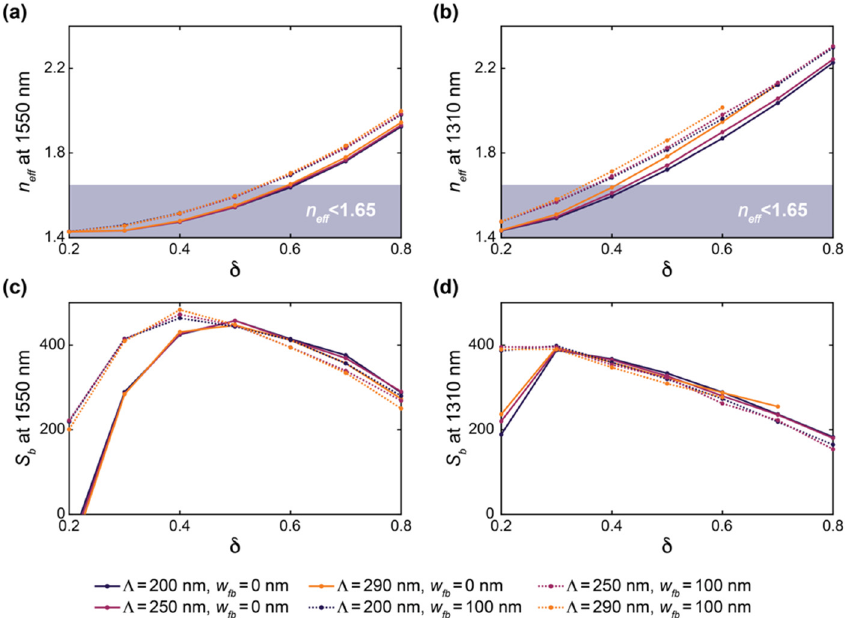
Figure 5. ( a , b ) Simulated n eff versus δ for SWG waveguides with Λ = 200, 250 and 290 nm, w = 500 nm, t = 220 nm, and w fb = 0 and 100 nm, operating with ( a ) 1550 nm and ( b ) 1310 nm light. The shaded area represents the region where n eff is below the substrate leakage loss cutoff of 1.65, as reported by Sarmiento-Merenguel et al. [80]. ( c , d ) Simulated S b versus δ for SWG waveguides with Λ = 200, 250 and 290 nm, w = 500 nm, t = 220 nm, and w fb = 0 and 100 nm, operating with ( c ) 1550 nm and ( d ) 1310 nm light. Simulations were performed using a 3D-FDTD approach with water as the cladding